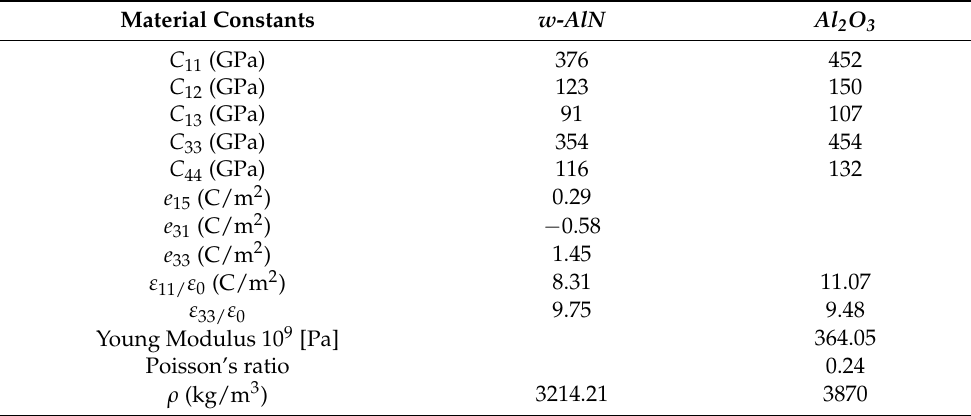
Table 3. Physical parameters used in the calculations.